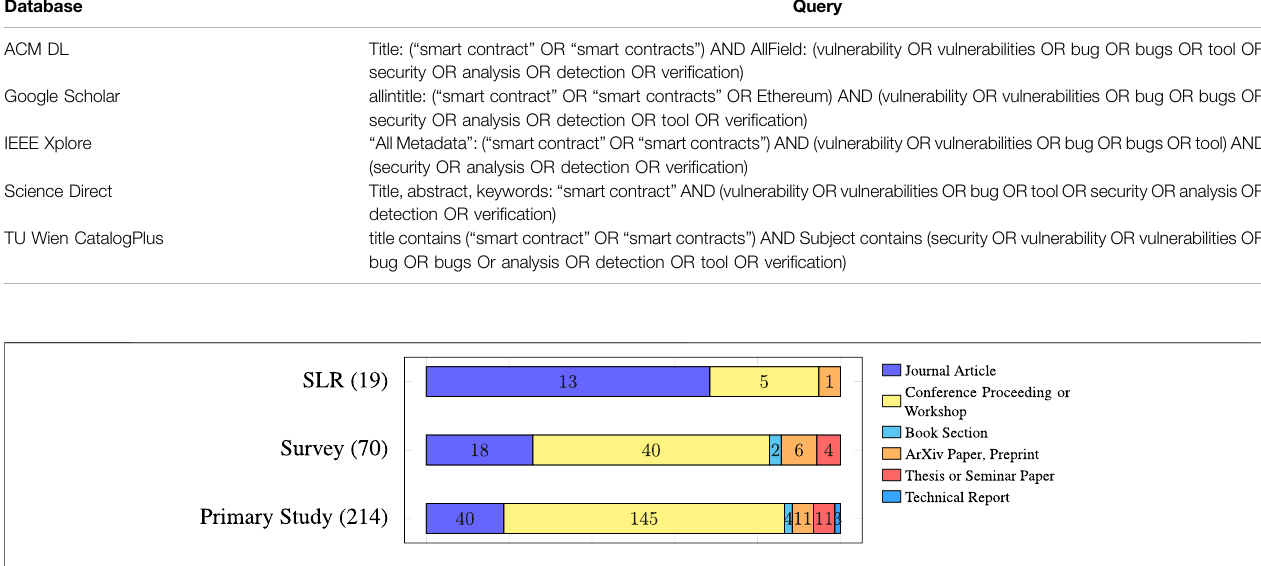
FIGURE 1 | Distribution of publication venues per publication